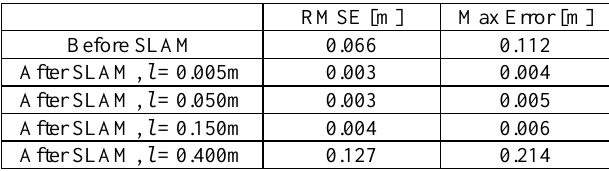
Table 5: Errors in estimated trajectory when varying the odometry noise. The bias in X and Y are set to 15mm and l is 0.4m.